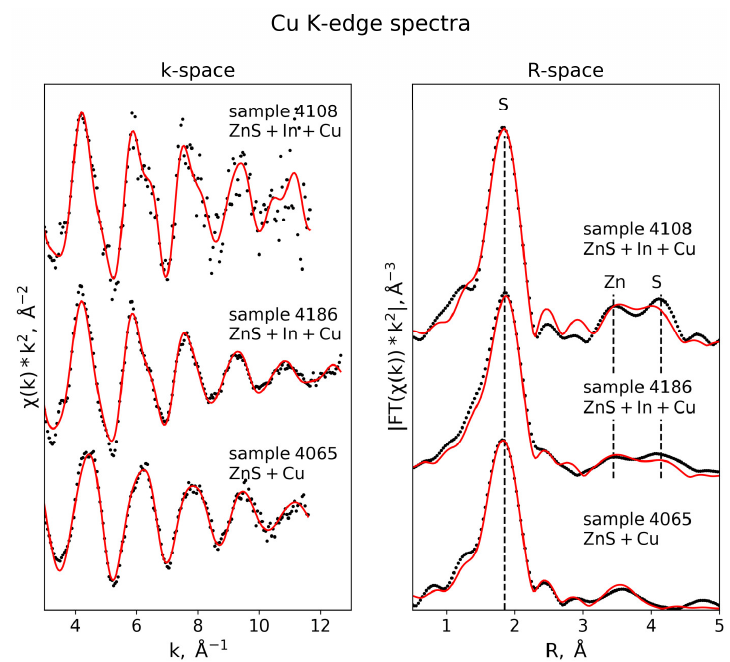
Figure 7. Cu K -edge EXAFS spectra of doped sphalerite samples (see caption of Figure 5 for explanation). In Samples 4108 and 4186, the first peak of the FT curves shows the presence of four S at 2.30–2.31 Å. The peaks at 3–4.5 Å (not corrected for phase shift) correspond to the second and third coordination Sample 4065.